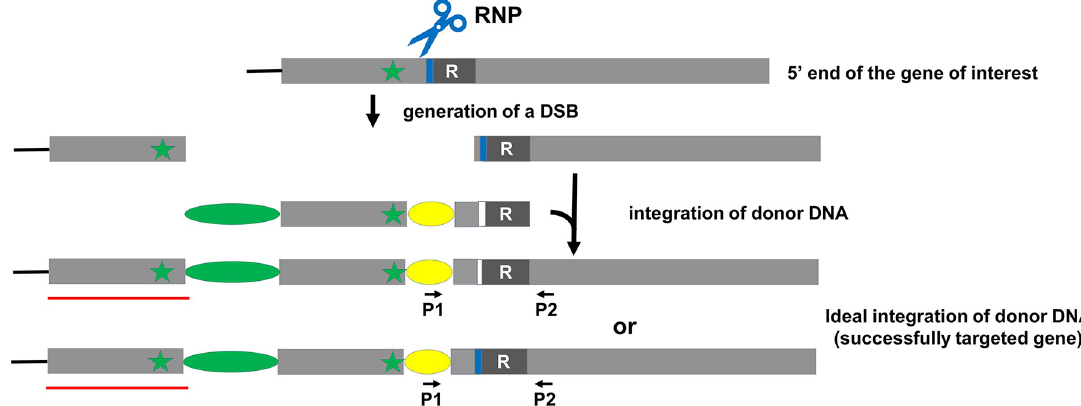
Fig 3. Schematic overview of TIM-based N-terminal tagging strategy using a single RNP. The 5’ end of the gene is shown as a grey box. The start codon is shown as a green star. The RNP target cut site is located downstream of the start codon. The PAM is shown as a blue bar on the gene. The donor DNA begins with a drug-resistance gene (green oval), then sequence homologous to the 5’ end of the target gene and continuing through the start codon, then sequence encoding the desired tag (yellow oval), and finally sequence homologous to that of the target gene beginning immediately after the start codon, including the RNP PAM modified with a silent mutation (white box), and continuing downstream for at least 20 bp (the “right” homology arm). The RNP can cut the wild-type gene, creating a DSB, but not the donor DNA or tagged gene if the donor DNA end is used as template to repair the DSB (upper diagram of “successfully targeted gene”). The new 5’ end created by the DSB also can be used as a template for repair, resulting in a tagged allele with a wild-type PAM sequence (lower diagram of “successfully targeted gene”). In these tagged alleles, the drug-resistance cassette is upstream of the gene. A portion (indicated by a red line) of the original gene remains immediately upstream of the drug-resistance cassette. To screen for positive clones, a 5’-end primer (P1) is designed to be complementary to the tag sequence (as illustrated here) or to sequence upstream of the tag; the 3’-end primer (P2) is designed to be complementary to sequence downstream of the homology